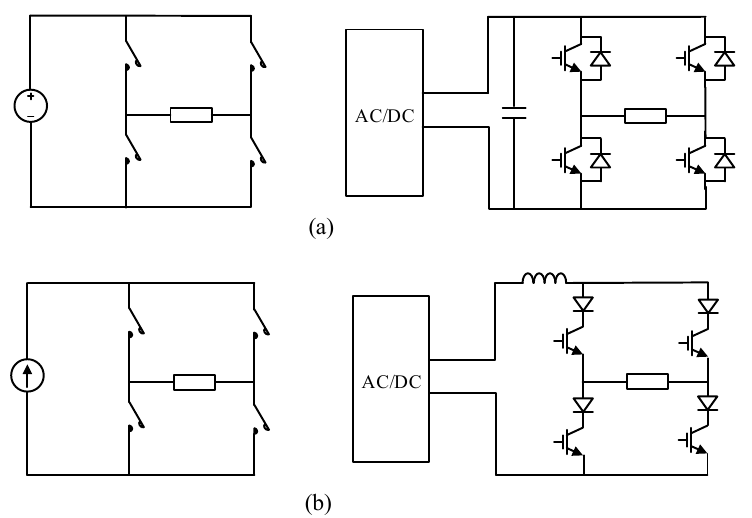
Figure 2. Typical topologies of inverters: ( a ) voltage source inverter, and ( b ) current source inverter.